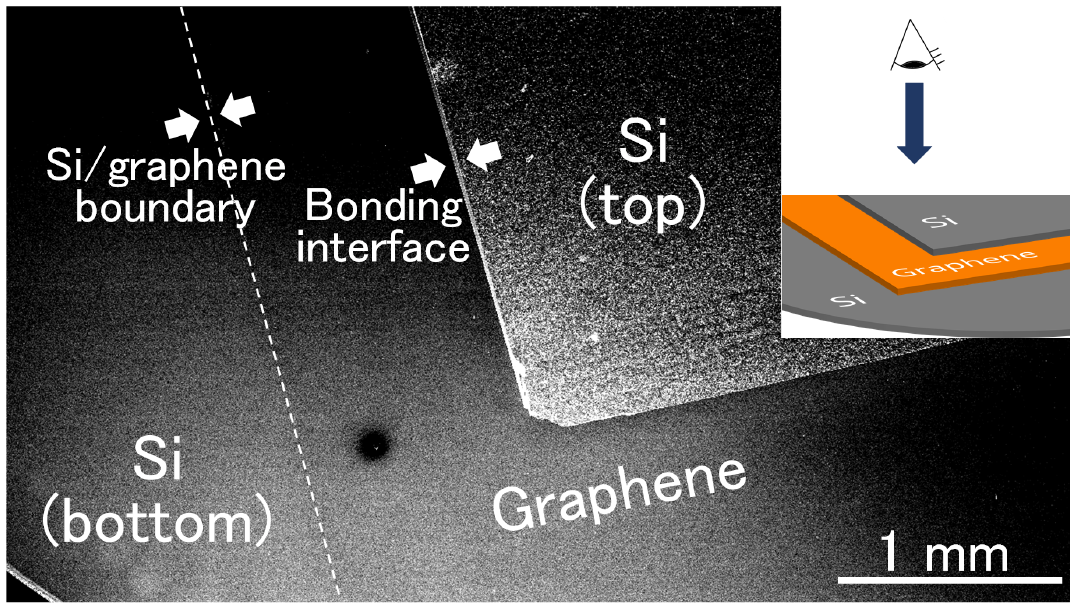
Figure 3. Plane-view scanning electron microscope image of the fabricated Si/graphene/Si double heterostructure.